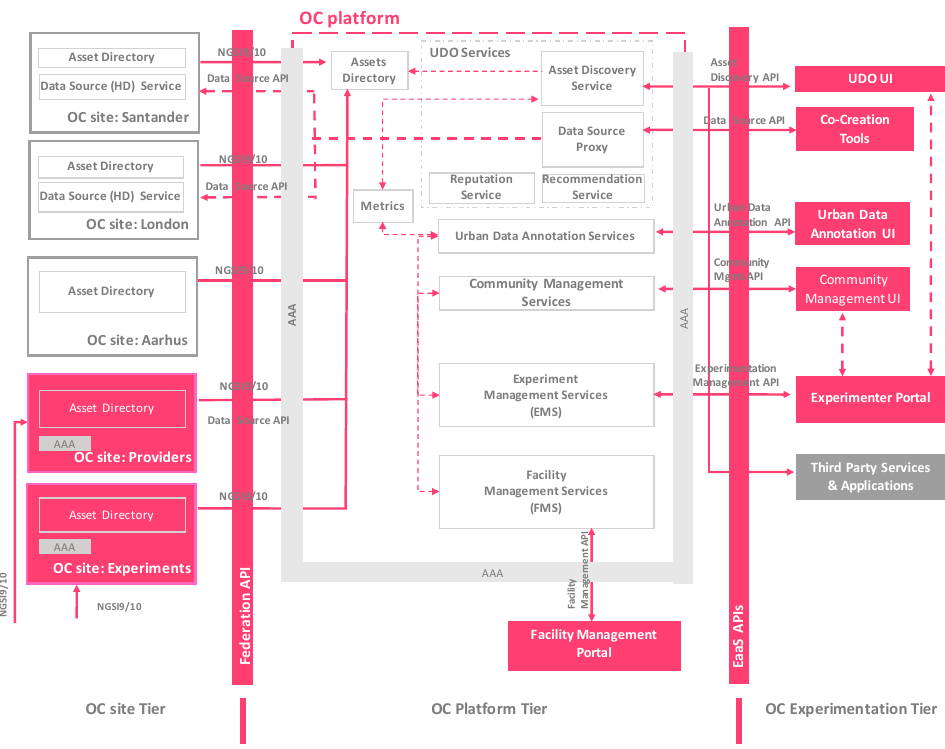
Figure 2. OrganiCity EaaS facility architecture instantiation.